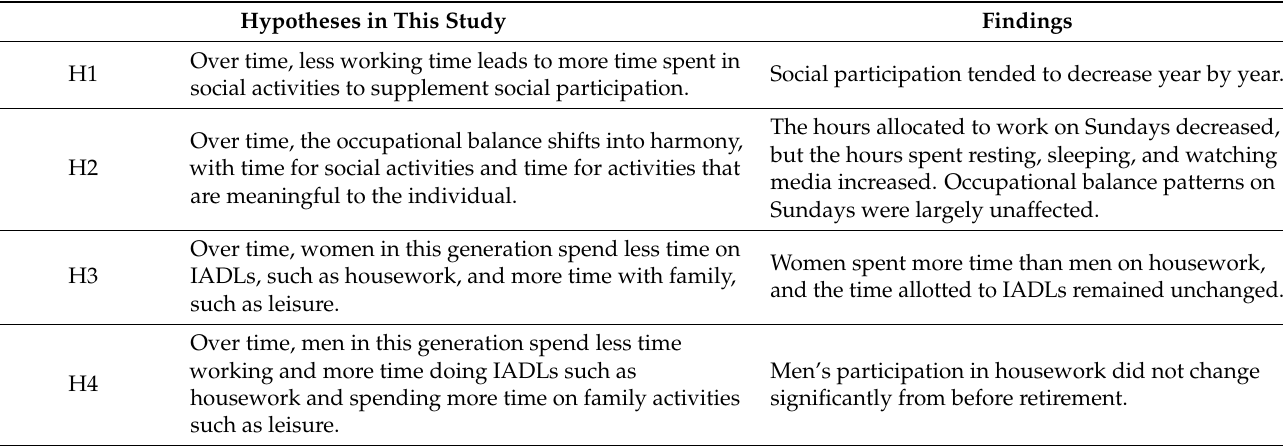
Table 2. Hypotheses and findings gained in this